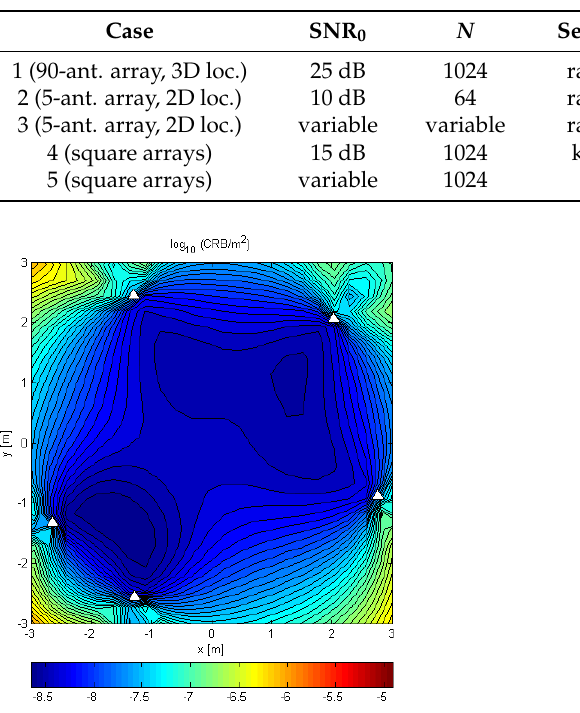
Table 2. Parameters used for the numerical results.